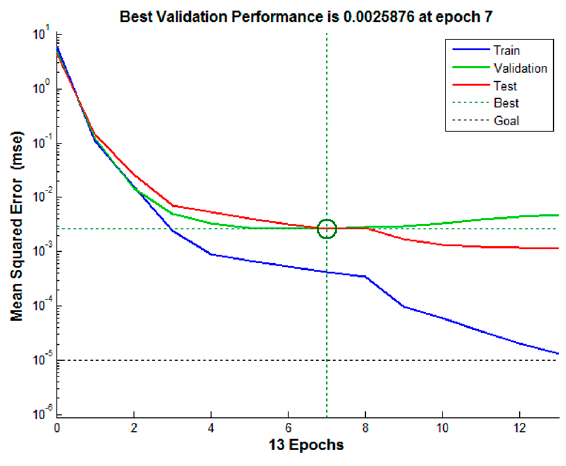
Figure 8. Variation of the mean square errors.